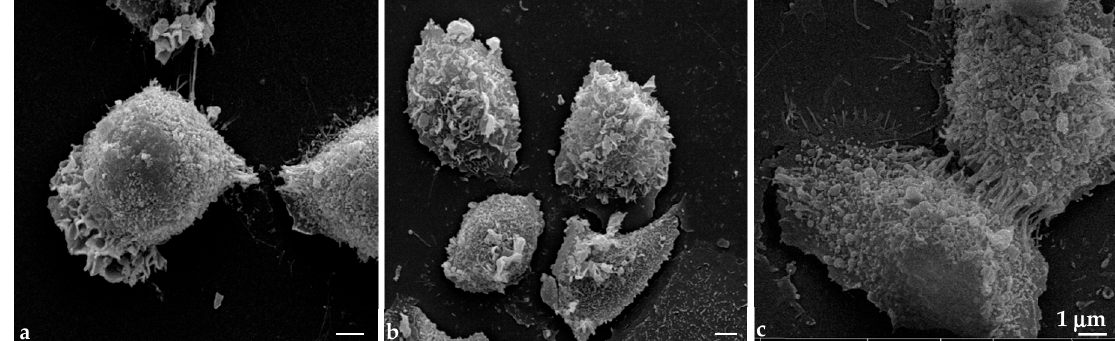
Figure 6. SEM images of SKBR3 control cells at 24, 48 and 72 h ( a – c respectively). After treatment with EO at different concentrations, cancer cells appeared very damaged. Figures 7–9 show important ultrastructural alterations of SKBR3 cells. The morphological alterations are clearly visible after only 24 h of treatment (Figure 7) with four different concentrations of EO (0.01; 0.1; 1.25 and 2.5 µ g/mL, respectively). Moreover, at higher concentrations (1.25 and 2.5 µ g/mL), SKBR3 cells appeared flat and adherent to the substrate, probably due the effect on cytoskeletal actin disorganization, as also shown by fluorescence microscopy analysis (Figure 4). When cells were treated with the lowest concentrations of EO (0.01 and 0.1 µ g/mL), at 48 h, the plasma membranes were entirely destroyed (Figure 8a,b). Cells showed plasma membrane alterations like those observed 24 h after treatment with the highest concentration (2.5 µ g/mL) of EO. Figure 8d shows cells treated with 2.5 µ g/mL for 48 h, in which the plasma membranes are completely damaged. Finally, as a dose-dependent effect, after 72 h, these morphological alterations were clearly visible in all SKBR3 cells treated with V. macrophylla EO (Figure 9a–c).